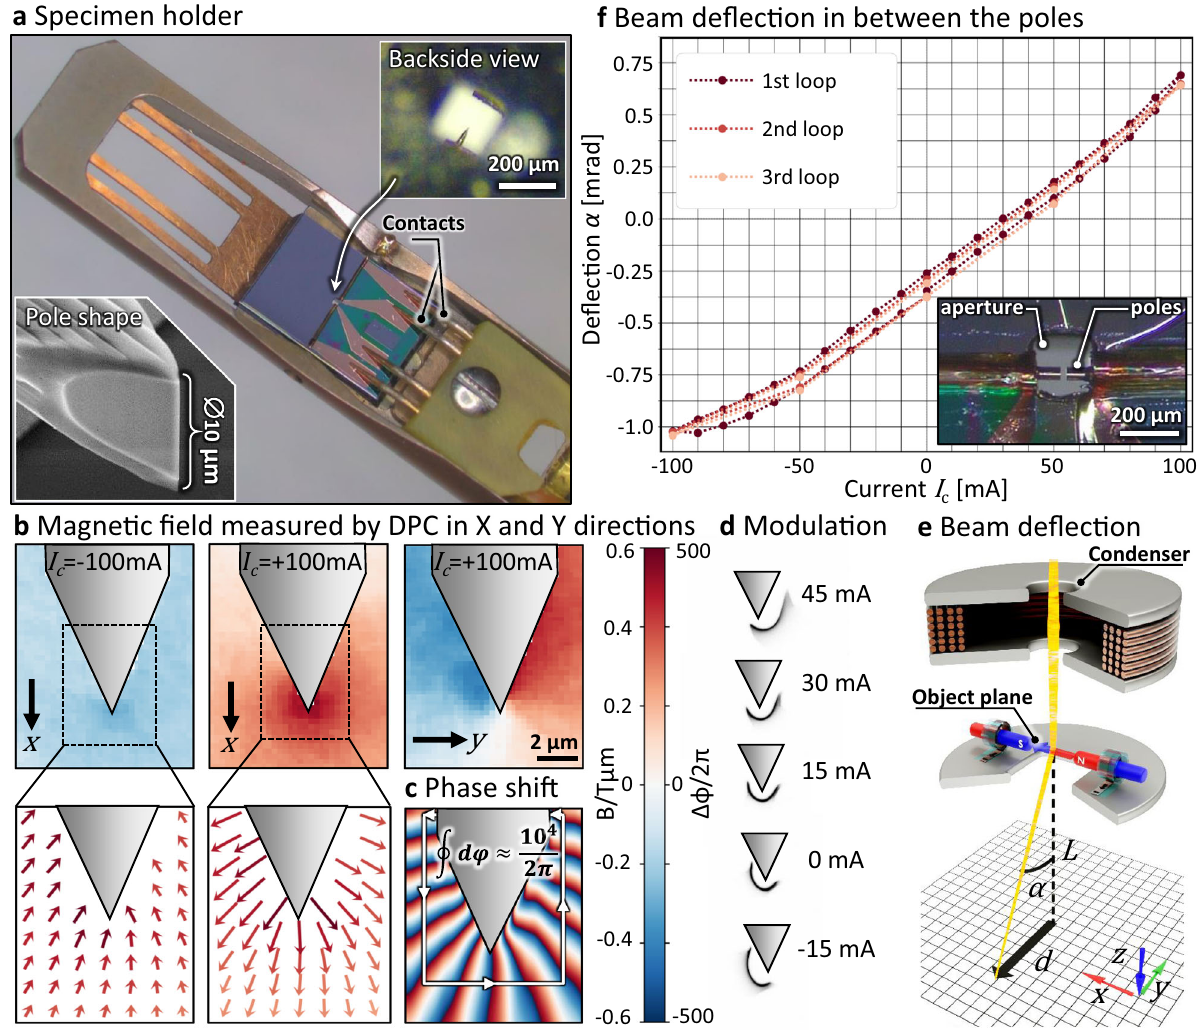
Fig. 3 Electron optical characterization of µ MCPO devices; electron vortex phase plate and dipole. a Protochips Fusion ™ TEM specimen holder with an inserted and electrically contacted chip carrying a complete set of self-assembled micro-coils and one micron-sized magnetic pole. The pole, made of a soft magnetic micro-wire, was tapered towards the tip (SEM overview in the bottom inset). The electron beam passes through the aperture in the Si chip (as shown in top inset). b Projected B - fi eld components in x and y direction at different excitation currents I c , and the corresponding B - fi eld vectors, as determined by differential phase contrast (DPC) measurements. c Phase of the electron wave at 100 mA coil excitation as reconstructed from the DPC measurements. The integration path for computing the vortex orbital angular momentum (OAM) is indicated revealing a strong >10 4 OAM. d A series of electron (half) vortex beams in the far fi eld (indicated defocus of − 0.4 µ m) at varying currents, demonstrating the functionality of the adaptive vortex phase plate allowing to modulate the electron beam and OAM on-the- fl y. e Schematics inside of a TEM of a dipole; the micro-coils generate a magnetic fi eld transversal to the e − beam; the de fl ection α can be derived from the camera length L and the displacement d of the center of mass of the beam measured on the detector in the far fi eld. f DPC measurements of the de fl ection angle of the beam in between the poles of the µ MCPO including variations at different sweeps exhibiting a nearly anhysteretic magnetization